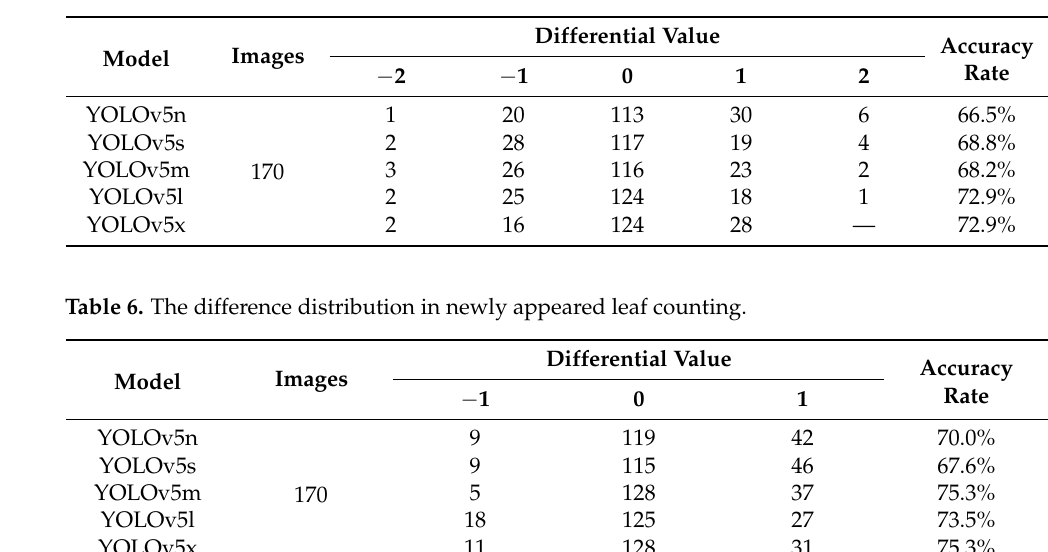
Table 5. The difference distribution in fully unfolded leaf counting.